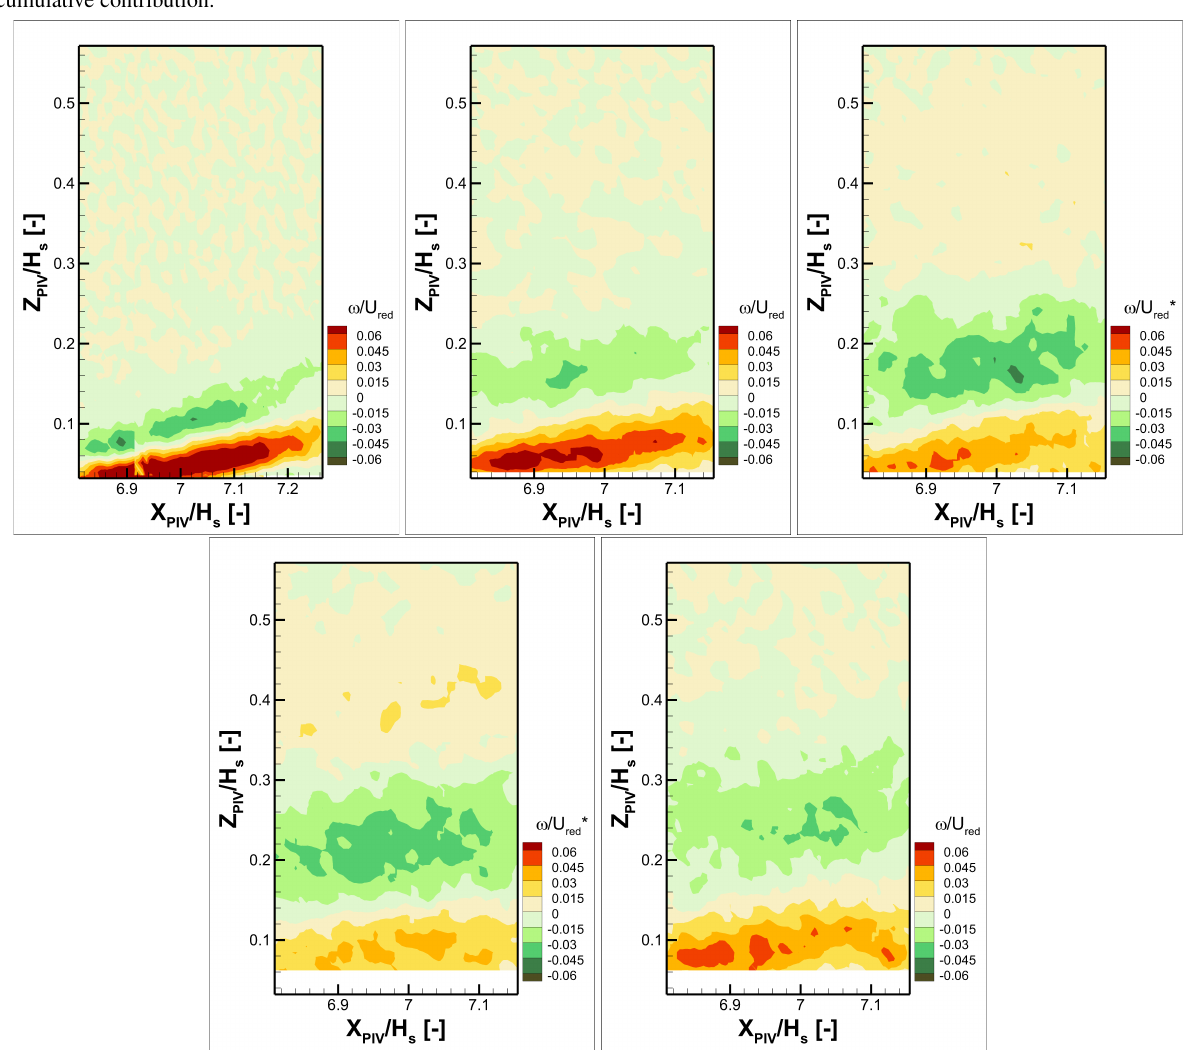
Fig. 5. The first POD modes of vorticity for the atmospheric boundary layer ABLM1-ABLM5 with a reference spire distance D4, from left upper corner to right bottom corner. H S is the inner height of the test section. Flow comes from left to right.